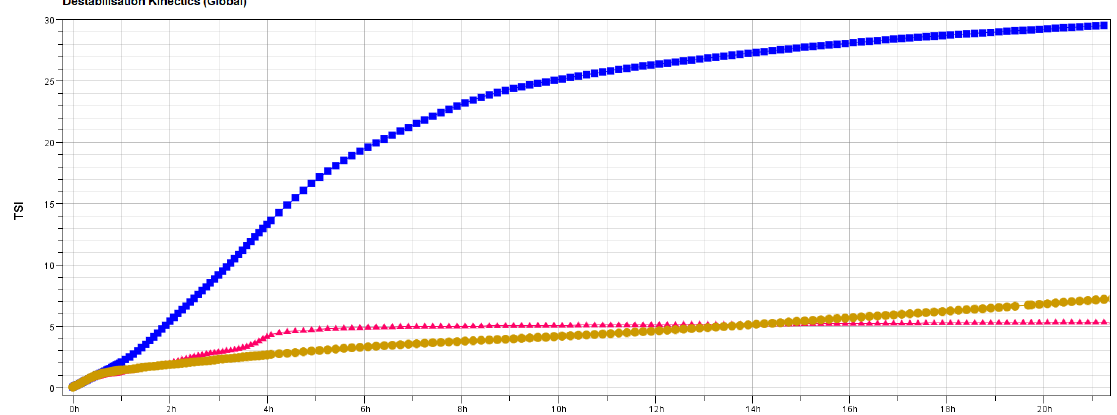
Figure 4. Short-term stability data; L1 TSI (blue), E1 TSI (yellow), and T1d TSI (red).